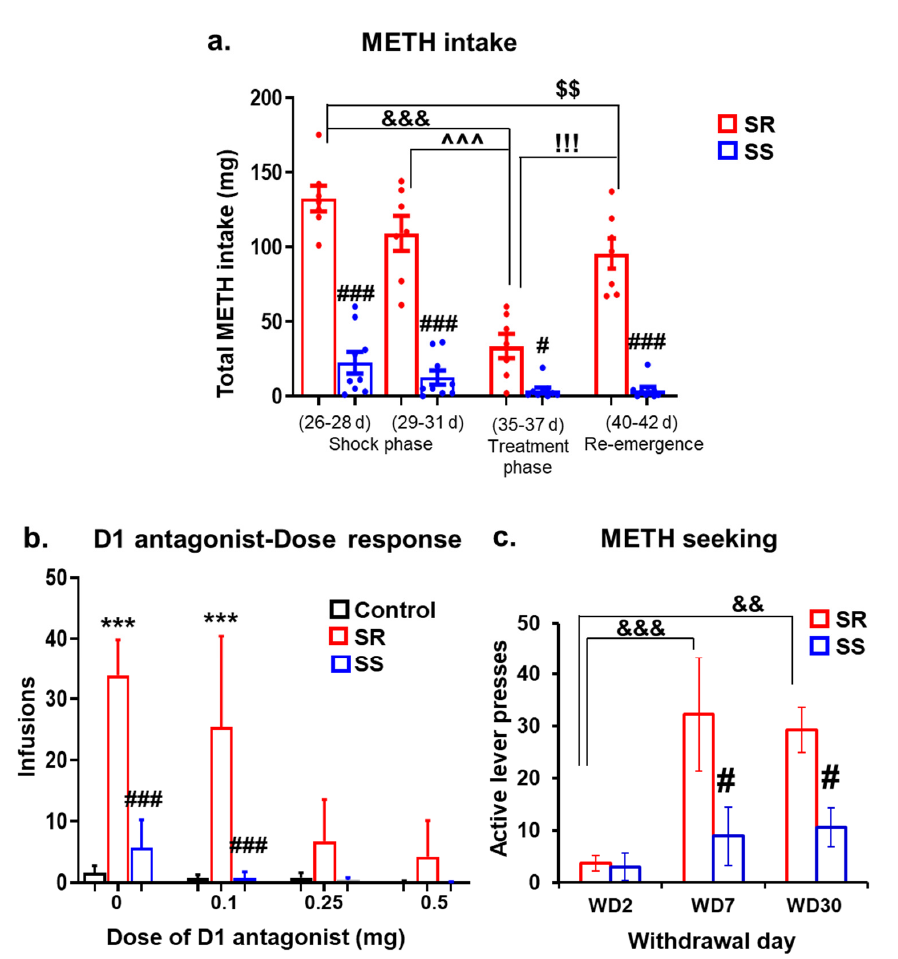
Figure 2. The DA antagonist, SCH23390, suppresses METH-taking behavior. ( a ) METH intake during footshocks and the effects of SCH23390 treatment and cessation of SCH23390 treatment. Increased intensity of footshocks reduced METH intake in SS but not in SR rats (# p < 0.05, ### p < 0.001, SR vs. SS). Administration of SCH23390 (35–37 d/days) before METH SA sessions significantly